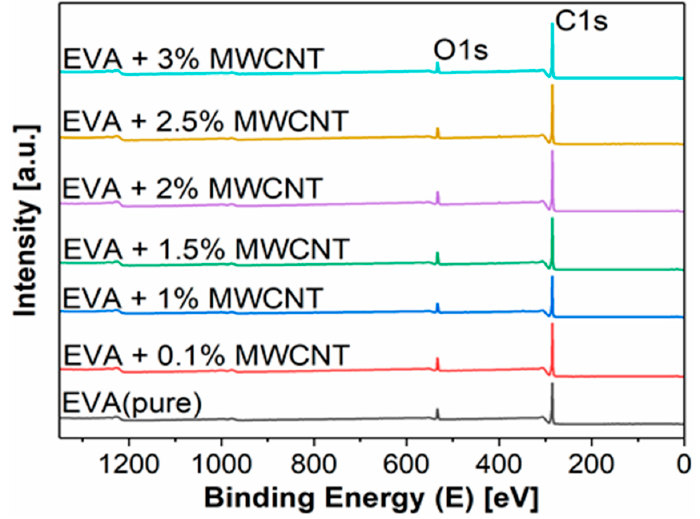
Figure 6. X-ray photoelectron spectroscopy (XPS) survey spectra of prepared samples of pure EVA fibers and EVA/MWCNT composites with various wt % of filler. Table 1. Apparent surface chemical composition of EVA matrix, MWCNTs and surface modified MWCNTs, and EVA/MWCNT fibers, as determined by XPS.